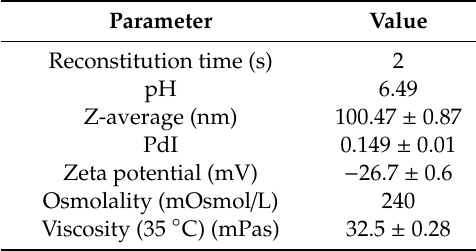
Table 8. Physicochemical parameters of the nasal